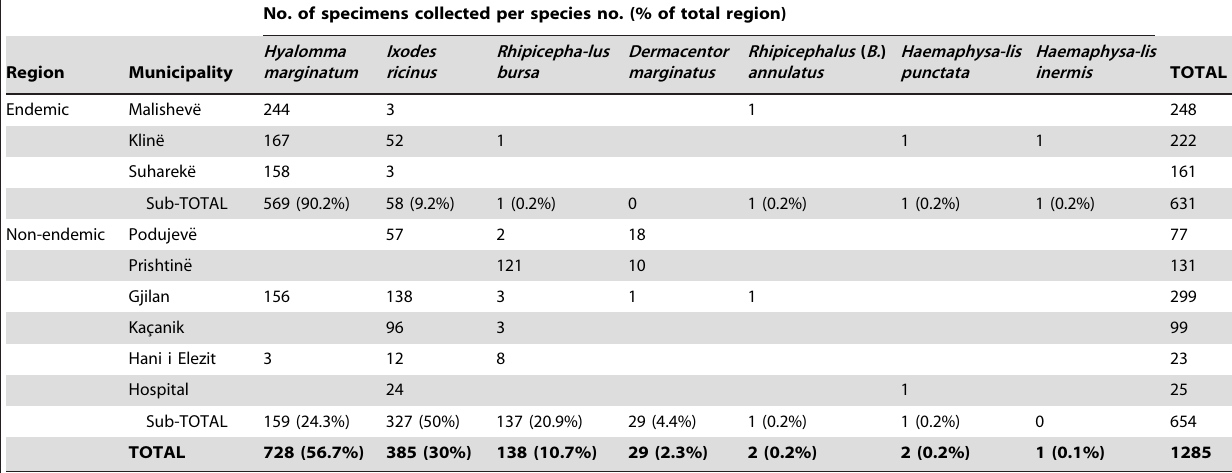
No. of specimens collected per species no. (% of total